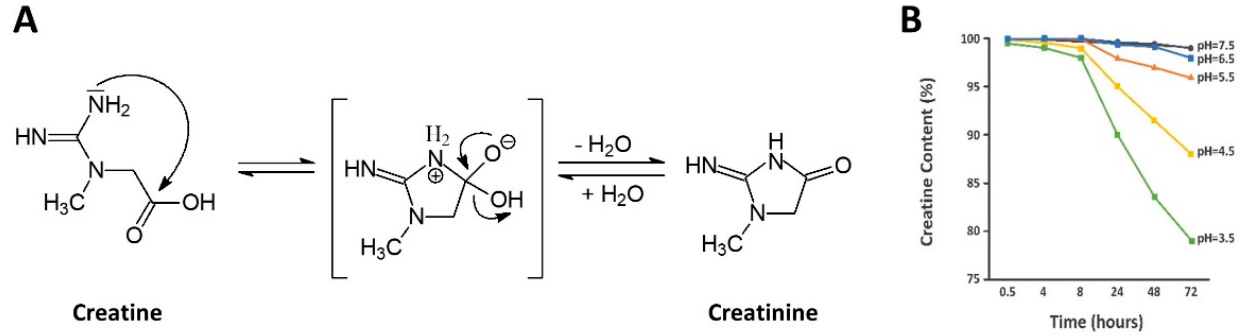
Figure 4. Conversion of creatine to creatinine ( A ) and influence of pH on creatine stability in solution ( B ). Creatine stability figure adapted from Howard and Harris [55].